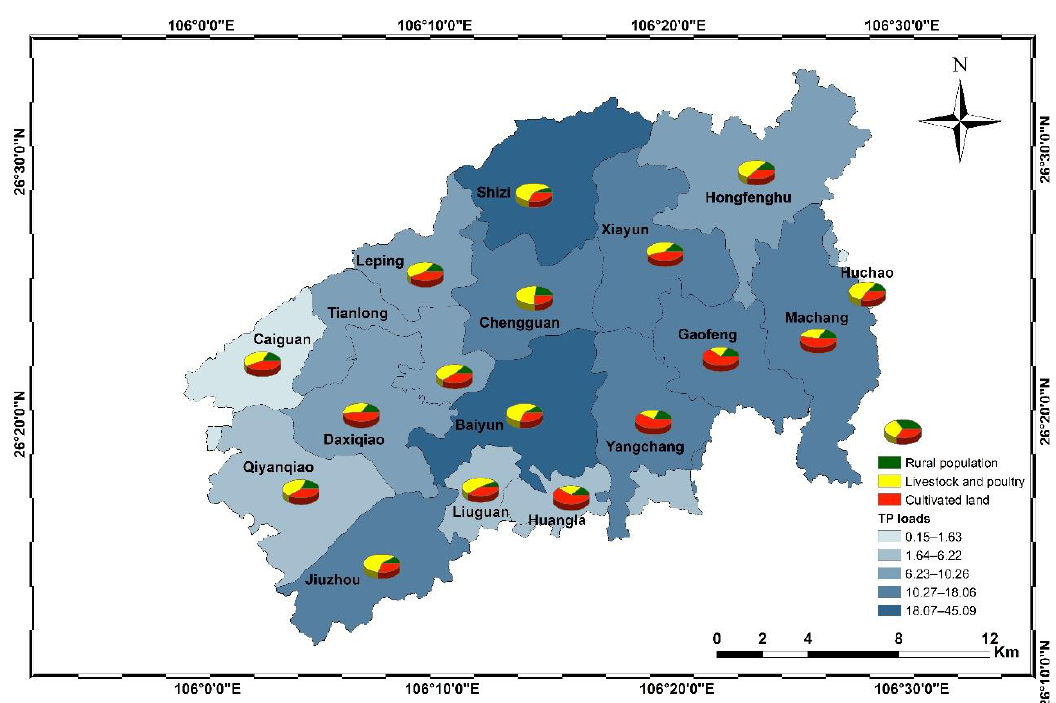
Figure 9. TP loads at the town scale in the Hongfenghu reservoir